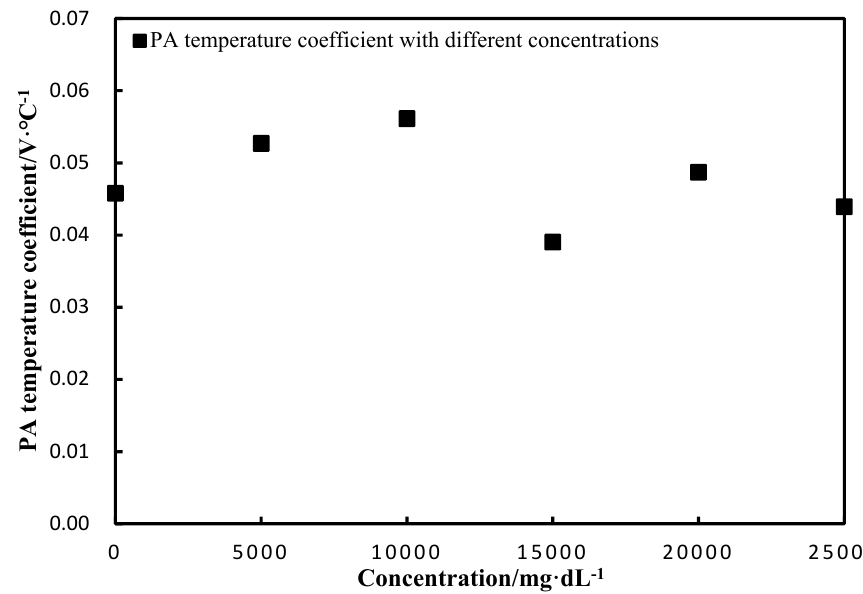
Figure 6. PA temperature coefficient with the concentration.